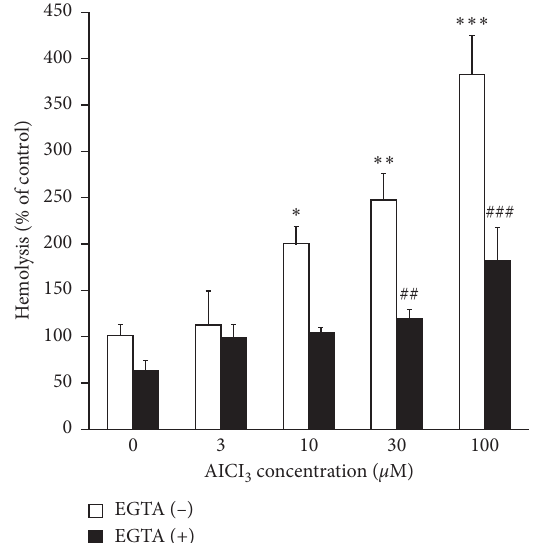
Figure 1: Effect of AlCl 3 on hemolysis in the absence and presence of EGTA. AlCl 3 increased hemolysis in a dose-dependent manner. EGTA (1mM) decreased the effect of Al on erythrocyte hemolysis. Data are mean ± SD of at least five independent